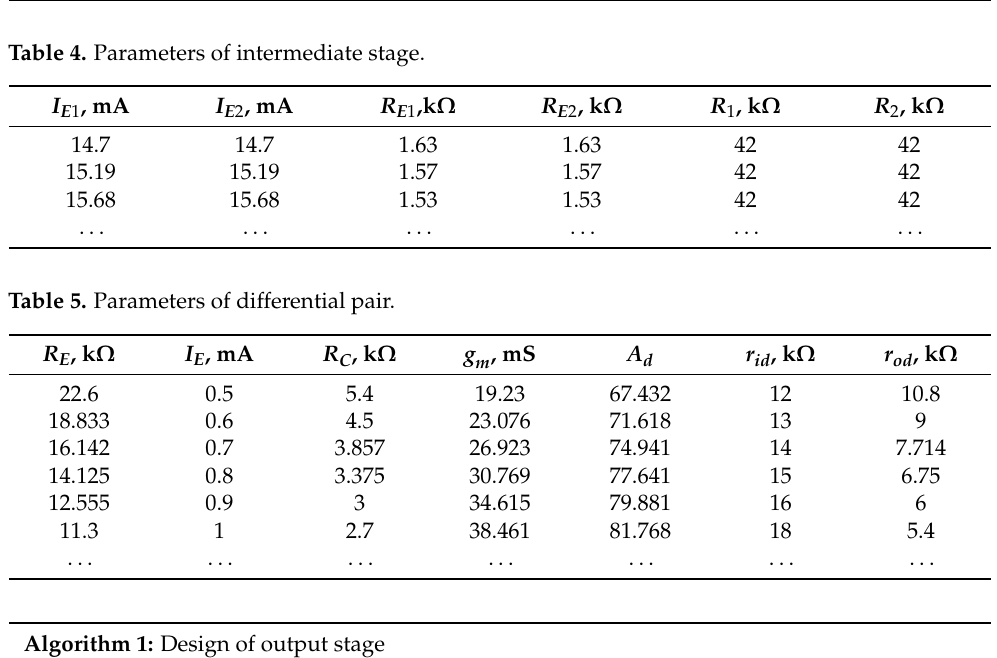
Algorithm 1: Design of output stage